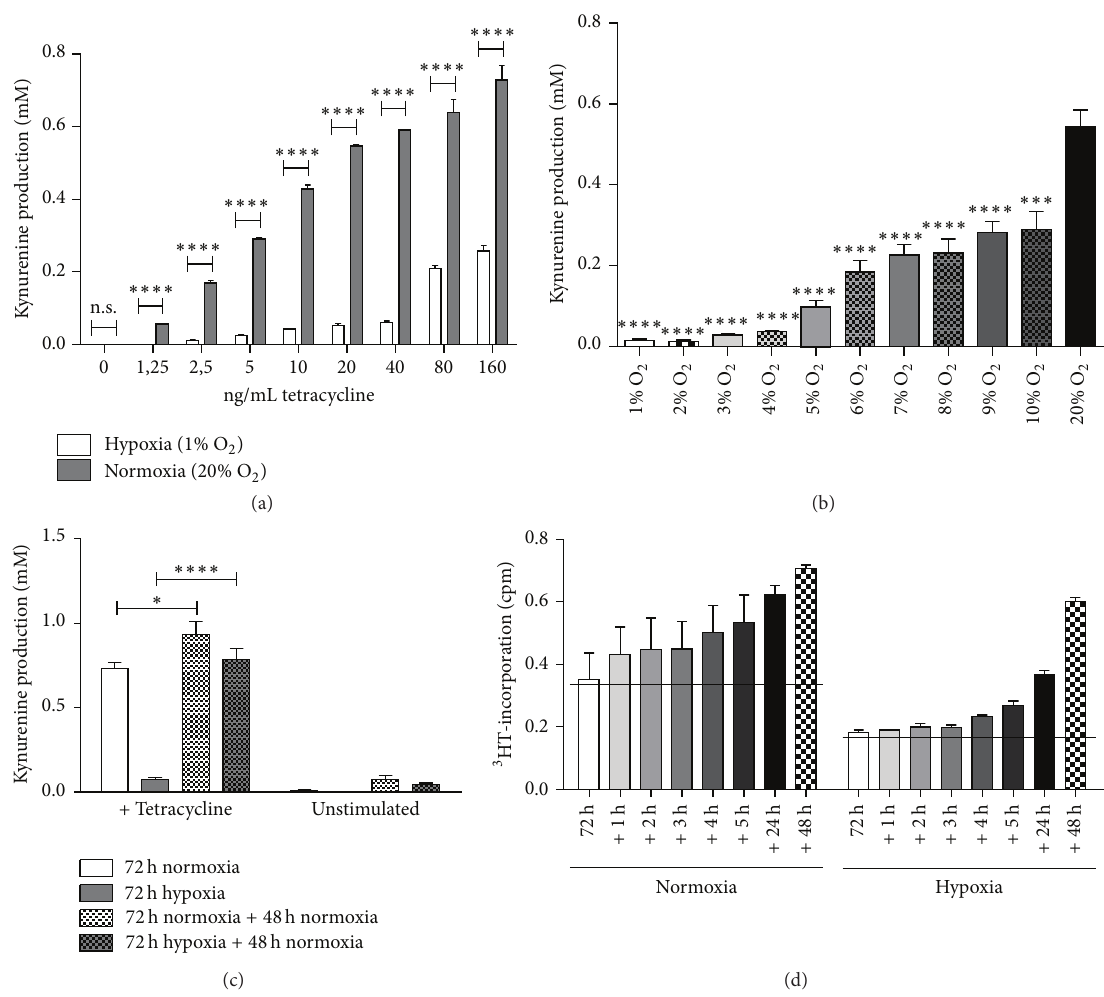
Figure 2: Loss of TDO activity in HeLa-hTDO cells under hypoxic conditions. (a) Kynurenine detection in cell culture supernatants of tetracycline (0–160ng/mL) stimulated HeLa-hTDO cells incubated under hypoxia (white bars) or normoxia (grey bars). (b) Kynurenine detection in cell culture supernatants in tetracycline stimulated (160ng/mL) HeLa-hTDO cells that have been incubated under different oxygen conditions (1–20% O 2 ) for 72 h. (c + d) Reoxygenation study: HeLa-hTDO cells were incubated under normoxia (20% O 2 ) or hypoxia (1% O 2 ) with or without tetracycline (40ng/mL) for 72 h. Then the kynurenine amount produced by TDO was detected in cell culture supernatants.Asecondexperimentalgroupwassubsequentlytransferredtonormoxiaandafterincubationofadditional48 h(c)or1–5h,24 h, and 48 h (d) the kynurenine amount was also detected in cell culture supernatants. In all experiments a significant alteration of kynurenine production under hypoxia as compared to the normoxia control is marked with asterisks ( ∗ 𝑝 ≤ 0.05 ; ∗∗∗ 𝑝 ≤ 0.001 ; ∗∗∗∗ 𝑝 ≤ 0.0001 , n.s. = not significant), two-tailed unpaired t -test; 𝑛 = 3 independent experiments with three replicates each. The bars indicate the mean value ± SEM.